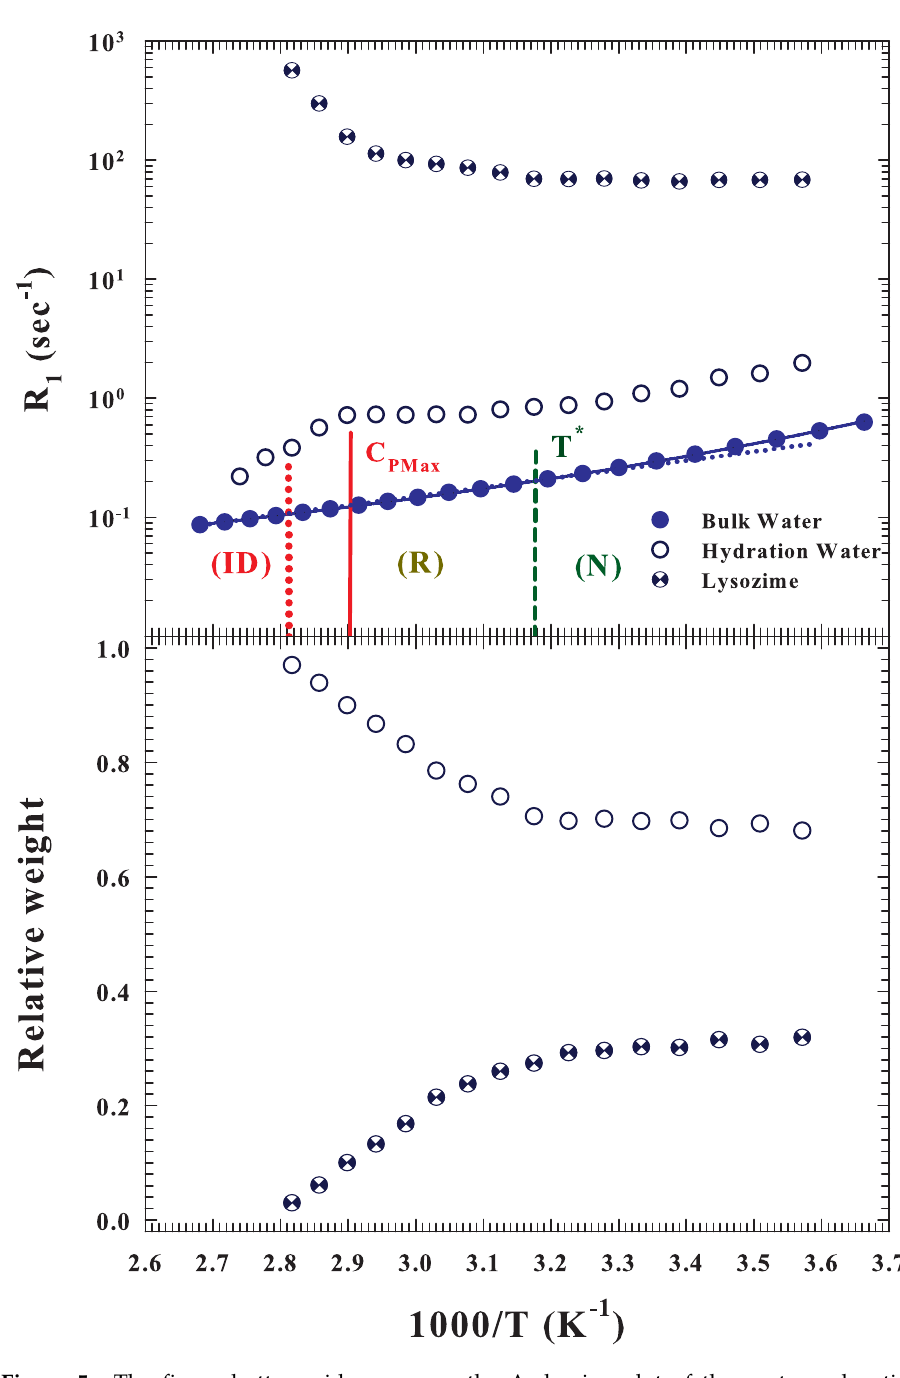
Figure 5. The figure bottom side proposes the Arrhenius plot of the proton relaxation rates ( R 1 = 1/ T 1 , measured in the lysozyme at h = 0.30) for the hydration and internal protein water and that of the pure bulk water; the two characteristic temperature corresponding to the N (cid:29) R −→ ID process together with that of the C p , max are also shown. Instead the bottom side of the figure illustrates the relative weight of the two protein water